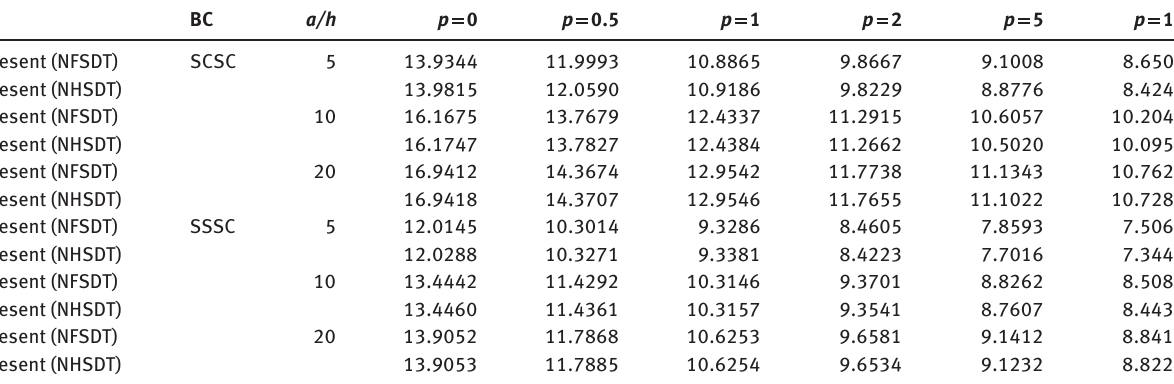
Table 9: Comparison study of the nondimensional fundamental frequency parameter ω = K = K w s